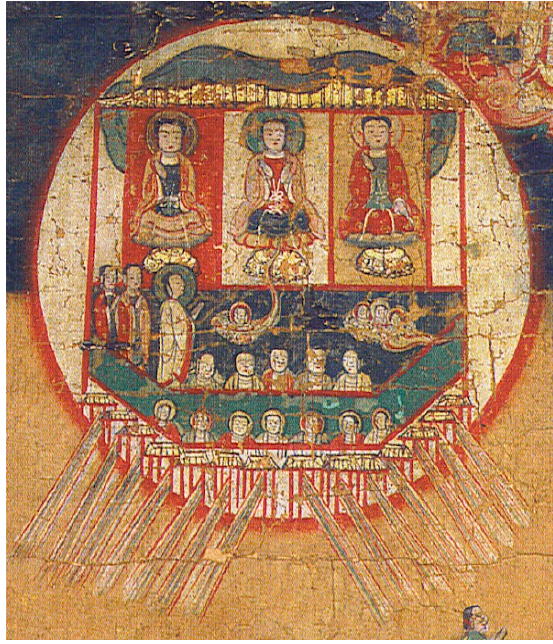
Figure 12. The Moon in the Liberation Light (Yoshida and Furukawa 2015, Plate 5).